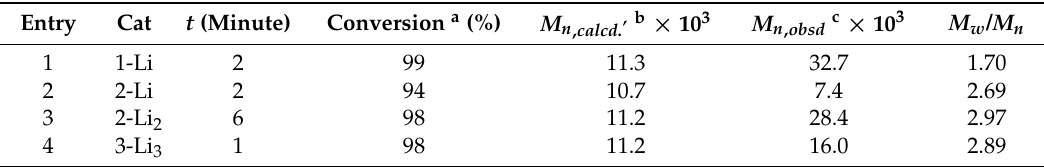
Table 1. Ring opening polymerization (ROP) of ε -caprolactone ( ε -CL) catalyzed by lithium complexes. Cat = catalyst, t = time.